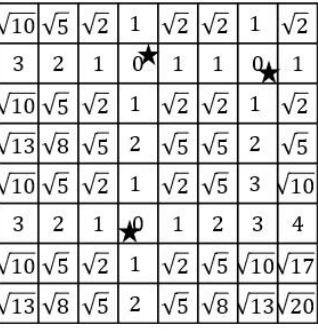
Figure 11. Example of the Step 2 Process.